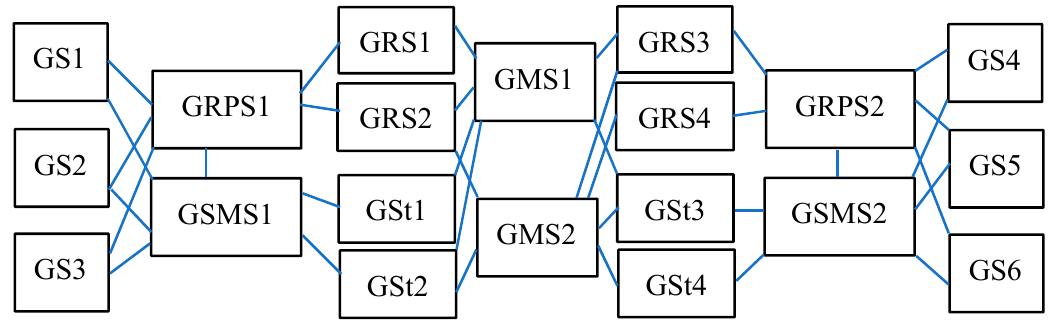
Figure 3. Exemplary inter-connections between gamification web services.